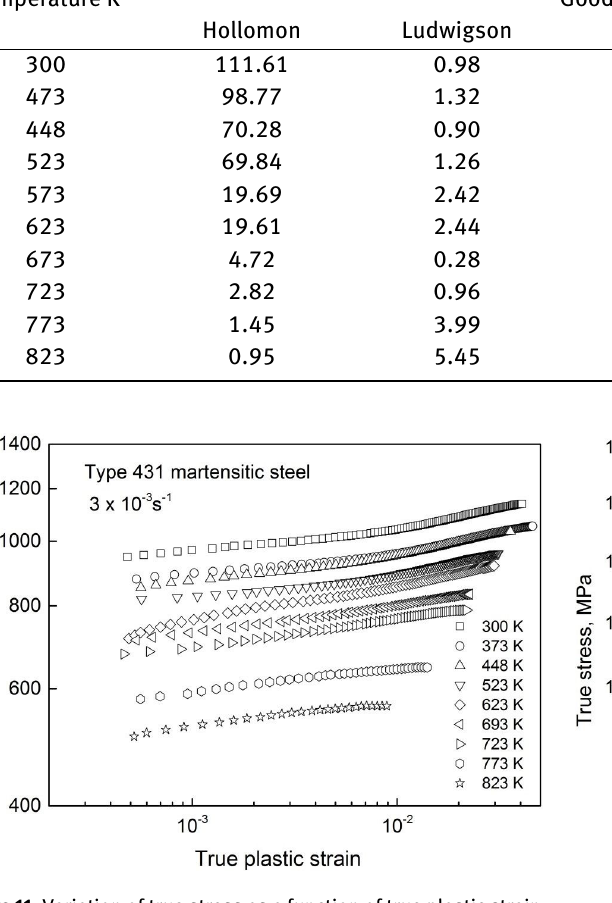
Table 3: Goodness of fit in terms of χ 2 , for various constitutive relations to the tensile flow behaviour of AISI 431 martensitic stainless steel. Temperature K Goodness of fit, χ 2